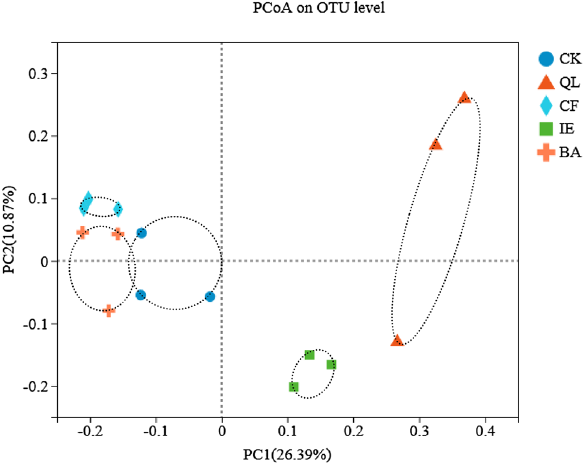
Figure 4. PCoA of bacterial community of the rhizosphere soil in continuous cropping lily. CK blank control, QL quicklime, CF chemical fungicide, IE inoculation with earthworms, BA biocontrol agent.